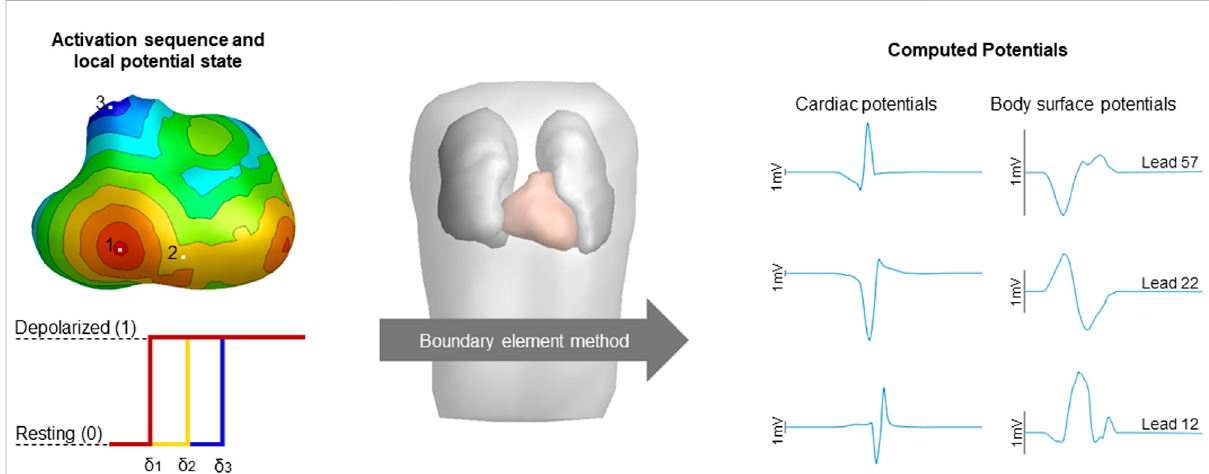
FIGURE 1 Schematic overview of the computation of potentials. The simulated activation sequences, constructed transmembrane potentials and the boundary element method compute the volume conductor effect to compute cardiac and body surface potentials. Activation timing is displayed from red (early) to blue (late), corresponding local potential states were displayed for three sites of interest with the color of the displayed potential corresponding to the local activation timing with δ denoting local activation timing. Computed cardiac and body surface potentials were displayed with the height of the black bar indicating 1 mV. The displayed body surface potentials are taken from the 64-lead setup, speci fi cally lead 12 positioned two intercostal spaces above V1, lead 22 positioned at the lower sternum and lead 57 positioned at the right side of the back are